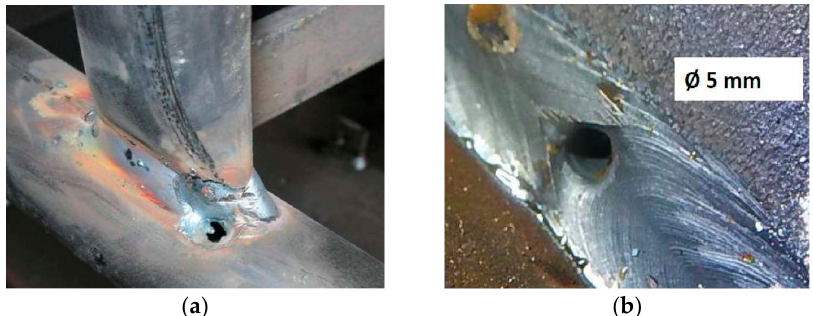
Figure 6. Spatter produced by the use of inadequate wire feed rate. 5. Figure 5. Undercuts caused by using a higher current than necessary ( a,b ). Figure 5. Undercuts caused by using a higher current than necessary ( a , b ).